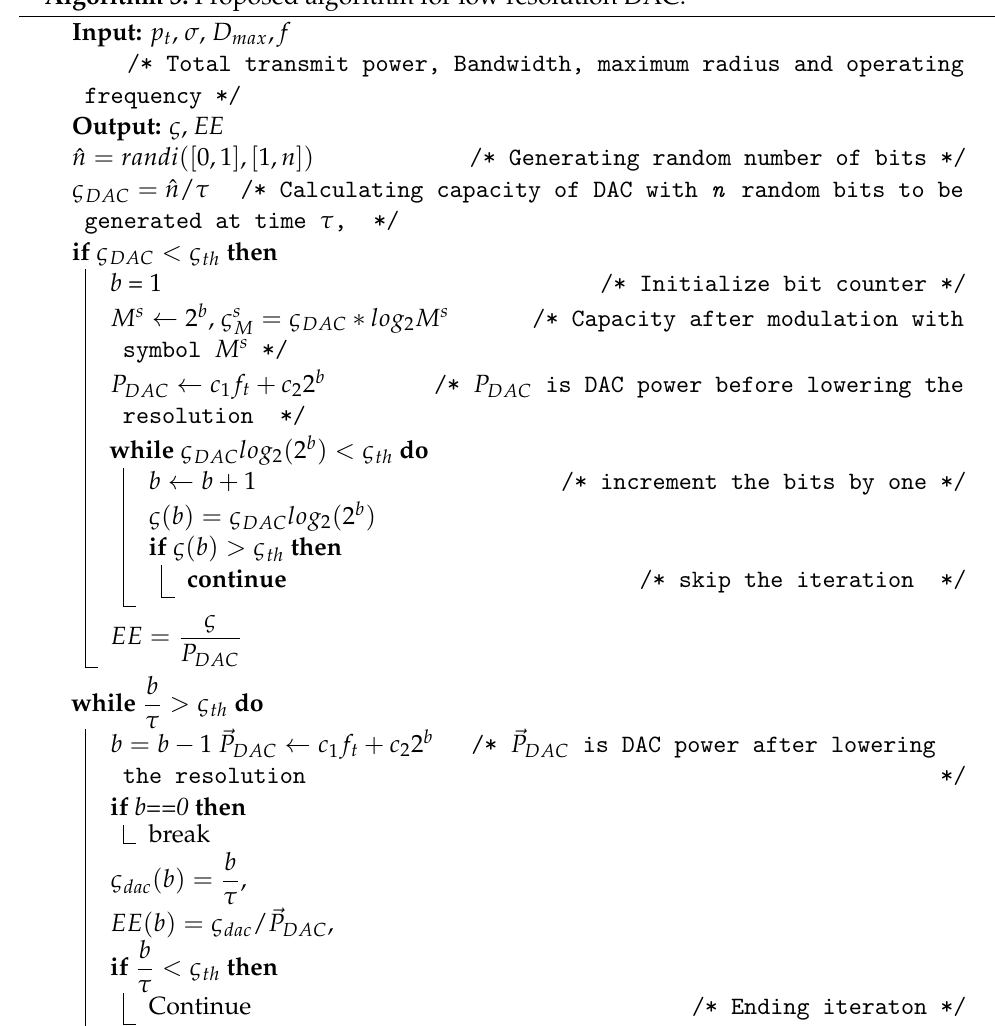
Algorithm 3: Proposed algorithm for low resolution